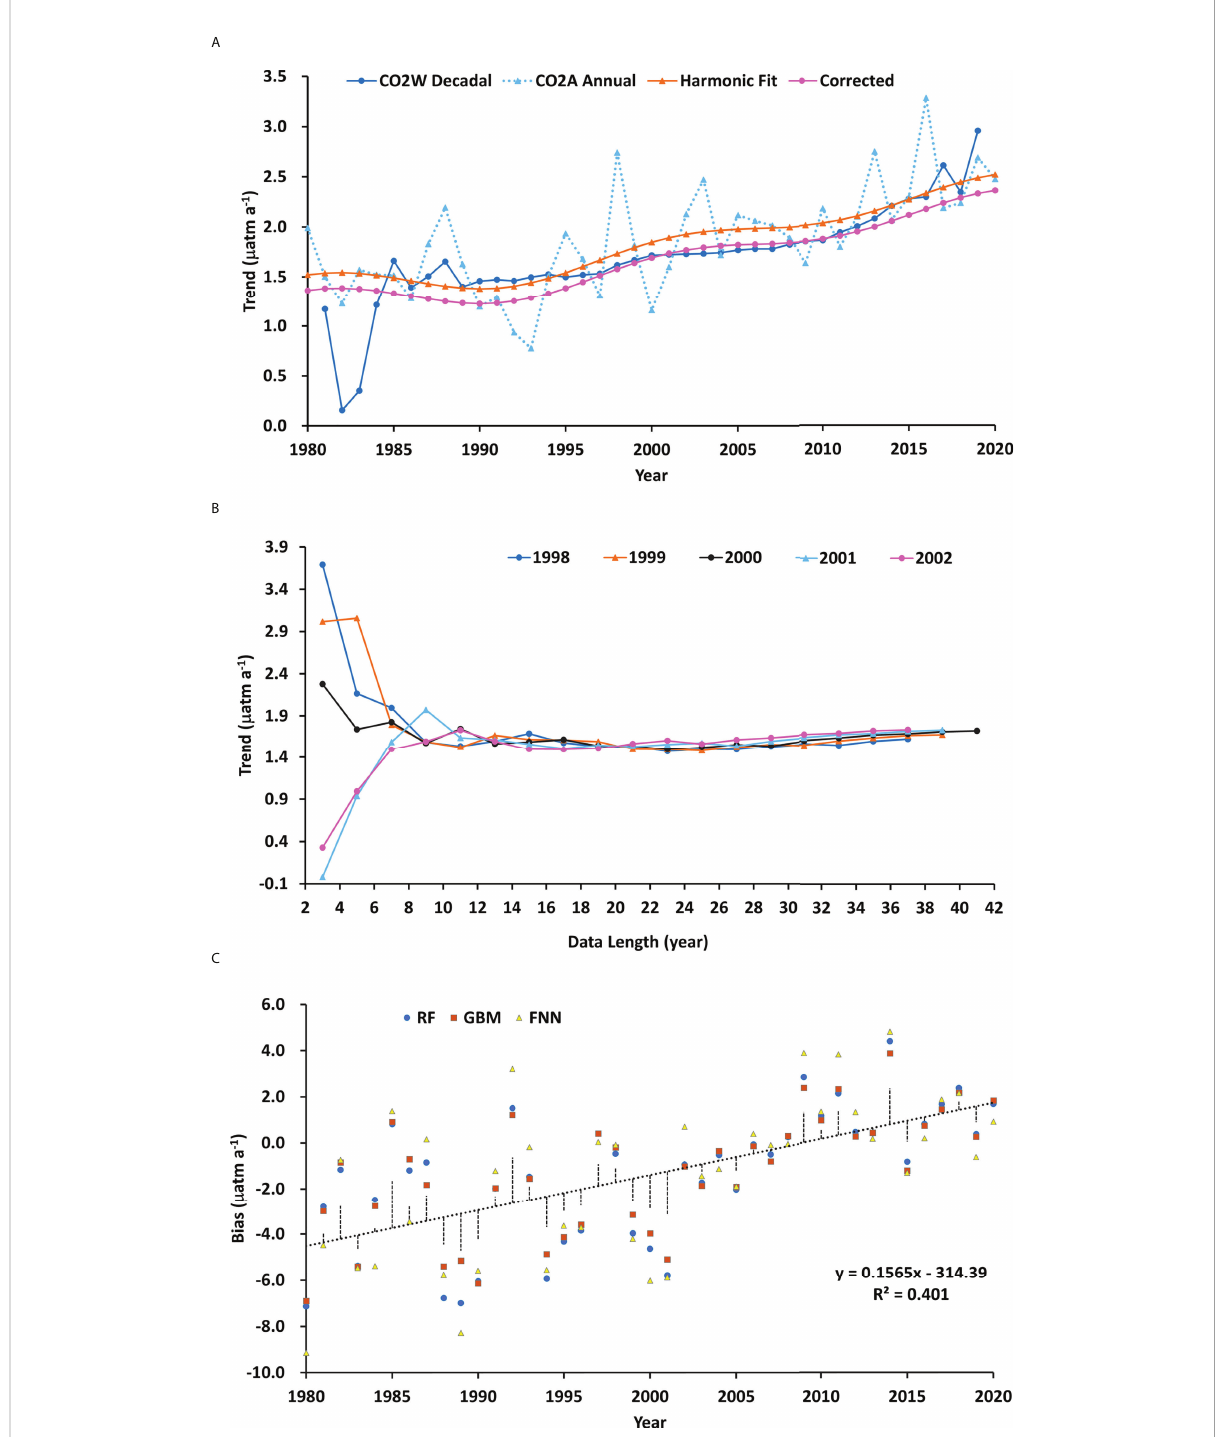
FIGURE 2 Trends extraction. (A) The trend of ocean CO 2 for a target year (blue) was estimated by using the iteration method with the longest data length around the year. The fi nal trends to be used for data normalization (magenta) are the corrected function fi tting trends (orange) of the annual increase rate of air CO 2 (cyan). (B) Examples of trend variations with data length for the target years 1998-2002. (C) The trend of CO 2 biases (prediction – observation) detected by LOYO with CO 2 data normalized by the uncorrected decadal trends of air CO 2 . The vertical lines show the standard residuals of the